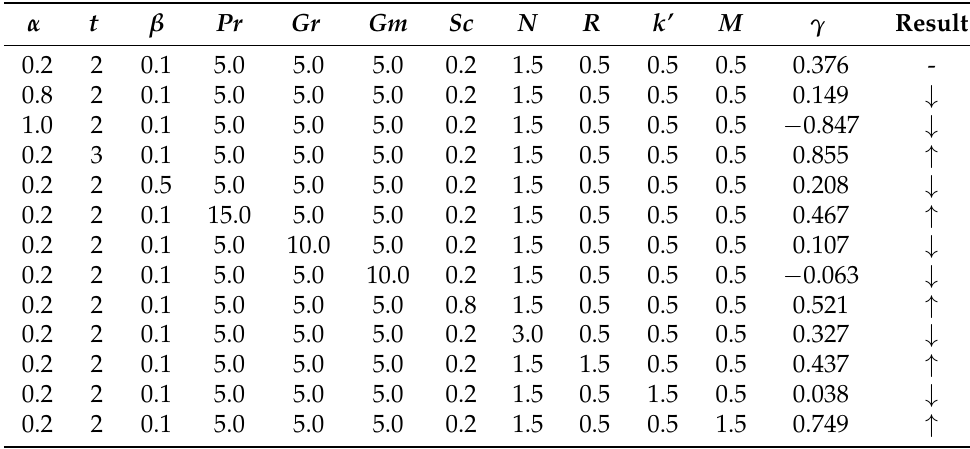
Table 3. Skin friction with various values of